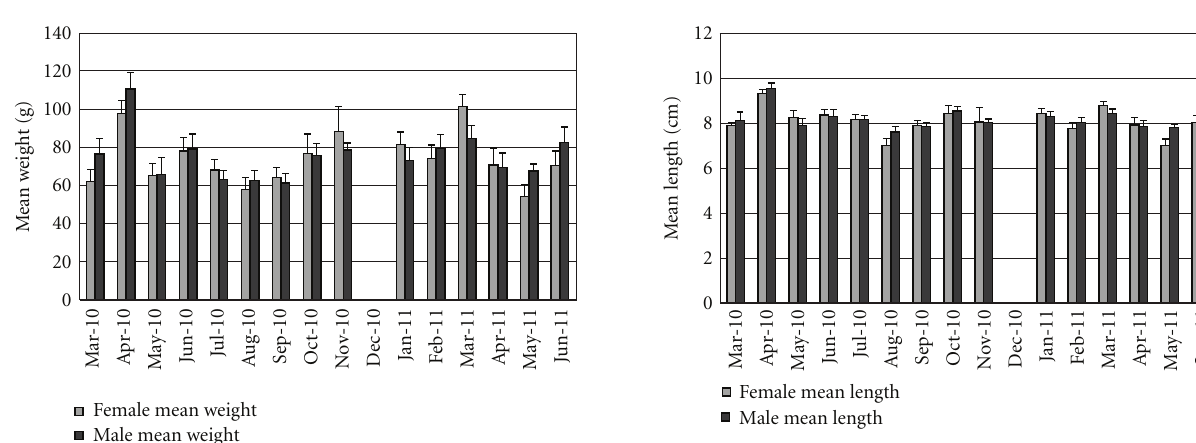
Figure 1: Mean weight ( ± S.D.) of female and male Mya arenaria sampled at Bannow Bay from March 2010 to June 2011.